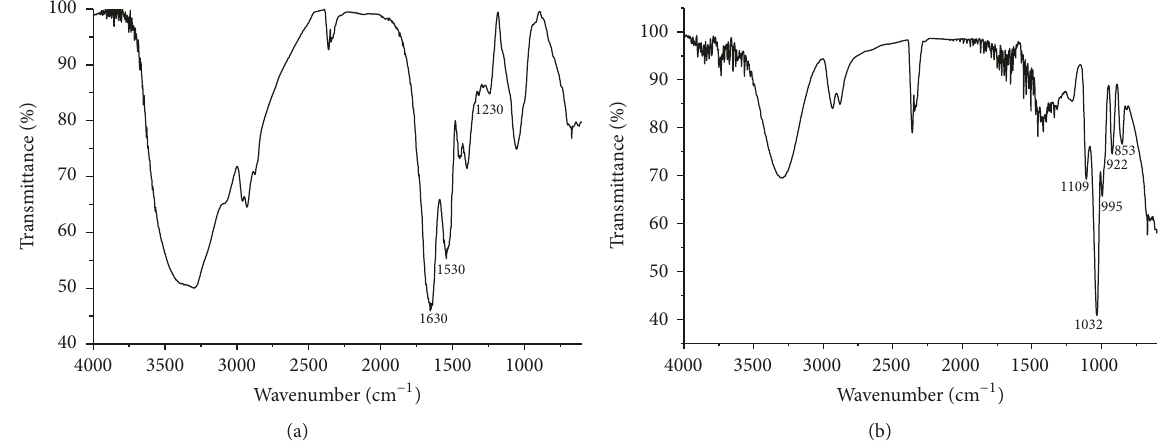
Figure 4: Fourier transform infrared spectra of negro bean protein concentrate (a) and pure glycerol